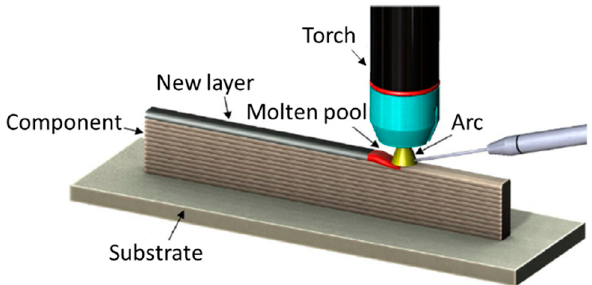
Figure 1. Schematic representation of the wire and arc additive manufacturing (WAAM) process (adapted from [6]).